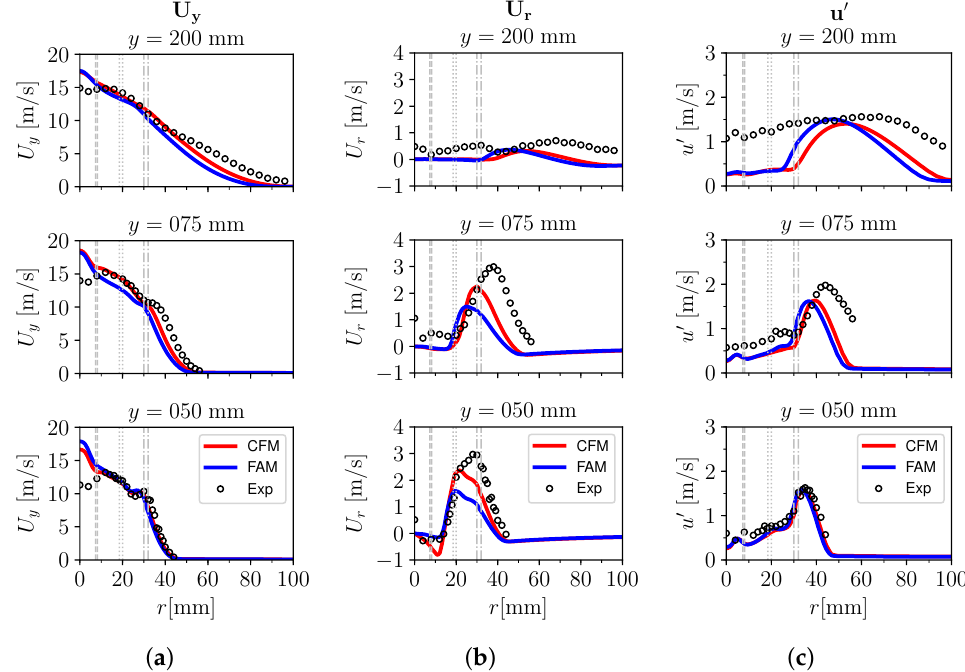
Figure 12. Case A-r: radial profiles of mean axial velocity U y ( a ); mean radial velocity U r ( b ); and mean turbulence intensity u (cid:48) ( c ); computed with different models at axial positions y = 50, 75 and 200 mm in comparison with experimental